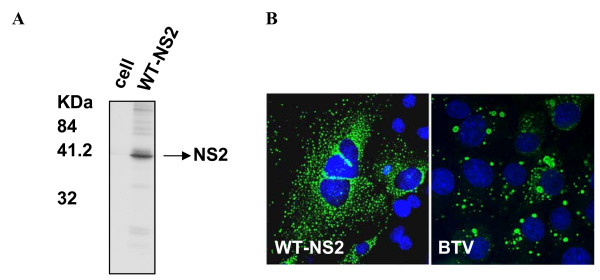
Full-length NS2 expression by constitutive BSR cells and its intracellular distribution. (A) Radiolabeled lysate of uninduced (left lane) and induced WT-NS2 cell line (right lane) were immunoprecipited using polyclonal anti-NS2 antibody. The names of the cell lines are given at the top of the panel. The position of NS2 fragment is indicated. (B) Cells expressing NS2 in absence of doxycycline (left) and unmodified BSR cells (right) infected with BTV-10 at 24 h p.i were immunolabeled with an anti-NS2 polyclonal antibody (green). Nuclei were stained with Hoechst 33342.